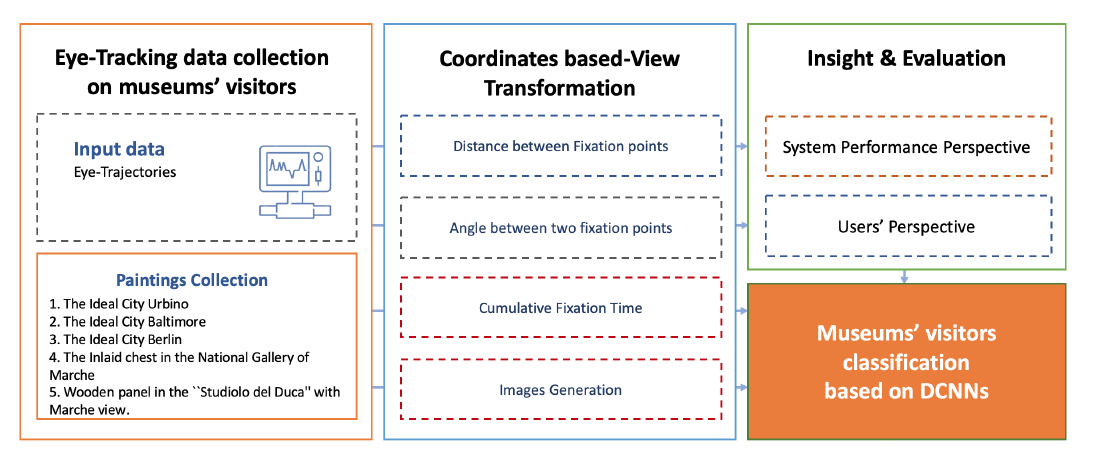
Figure 1. Overview of our Visual Attentive Model (VAM) for museums’ visitors